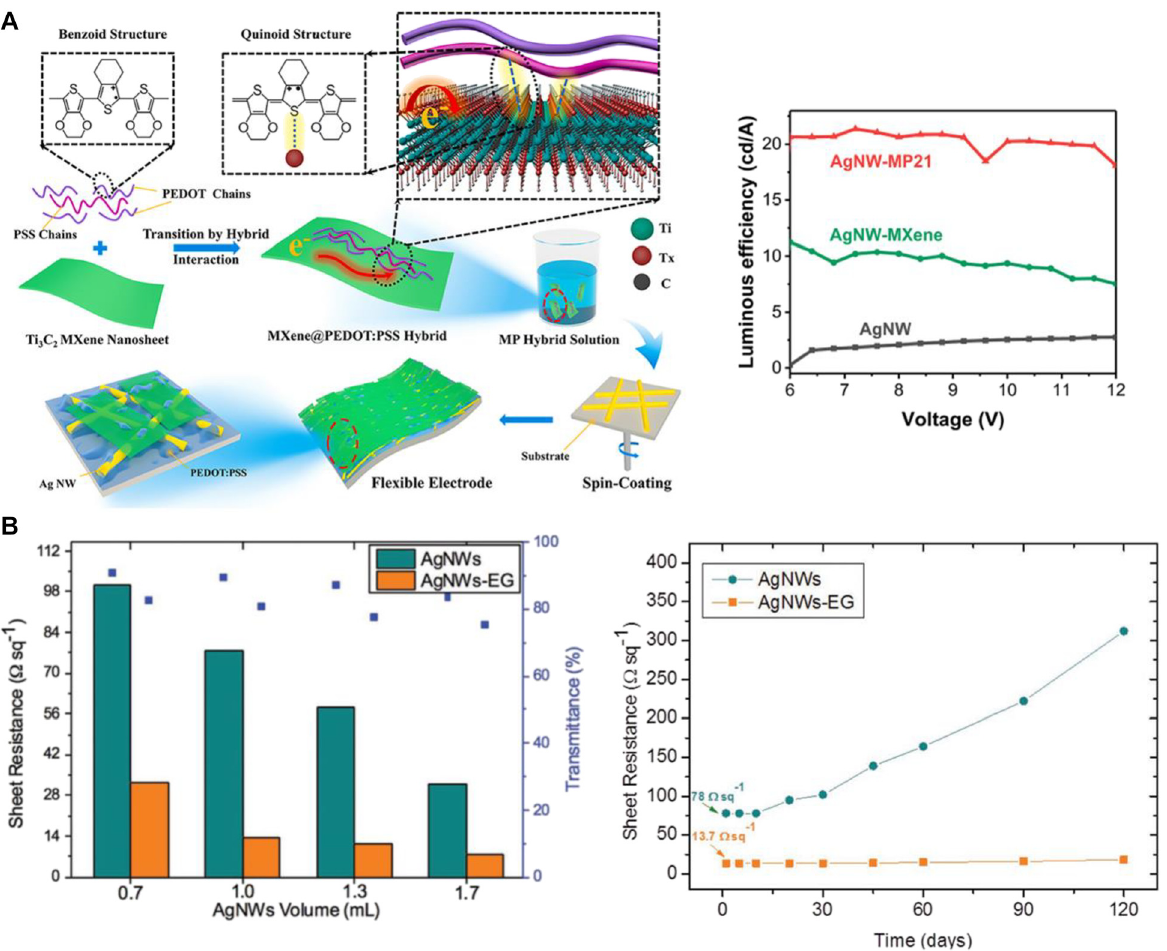
Figure 2: Integration of metallic NW and 2D materials for the flexible transparent electrodes. (A) Left, schematic illustration of the fabrication process of AgNW-MXene@PEDOT:PSS hybrid FTEs. Right, luminous efficiency of AgNW, AgNW-MXene hybrid, and AgNW-MP21 hybrid FTEs on silicon. Reproduced/adapted with permission from Bai et al. [24]. Copyright 2020 Elsevier Ltd. (B) Left, sheet resistance and transmittance of AgNWs and AgNWs-EG fi lms at different AgNWs volumes. Right, long term sheet resistance of AgNWs and AgNWs-EG with air exposure. Reproduced/adapted with permission from Ricciardulli et al. [25]. Copyright 2018 Wiley-VCH Verlag GmbH & Co. KGaA, lower the sheet resistance ( R ) without noticeable decrease s of transmittance and simultaneously decreased the roughness from 78 Ω /sq to 13.7 Ω /sq and from 16.4 to phene (EG). In detail, the solution containing silver nano- wires is fi rst sprayed onto fl exible substrate, polyethylene naphthalate (PEN), followed by EG dispersion. In paper further demonstrated the implementation of the Figure 2B, sheet resistance and transmittance of various electrode as an anode in an organic solar cells (OSC) and volume of silver nanowires with the EG layer are compared polymer LEDs (PLEDs). with the pristine Ag nanowires. Moreover, the samples were exposed in the air for 120 days for long-term stability (Figure 2B). During those times, the sheet resistance of the prevents metal nanowires from oxidization. Silver nano- hybrid material remained constant while that of the wire, which is one of the most frequently used metal wires pristine sample increased after 10 days of exposure. They as a bottom electrode of perovskite solar cells (PVSC) has reported that by deploying the EG layer, they were able to corrosion issues caused by the release of halide species